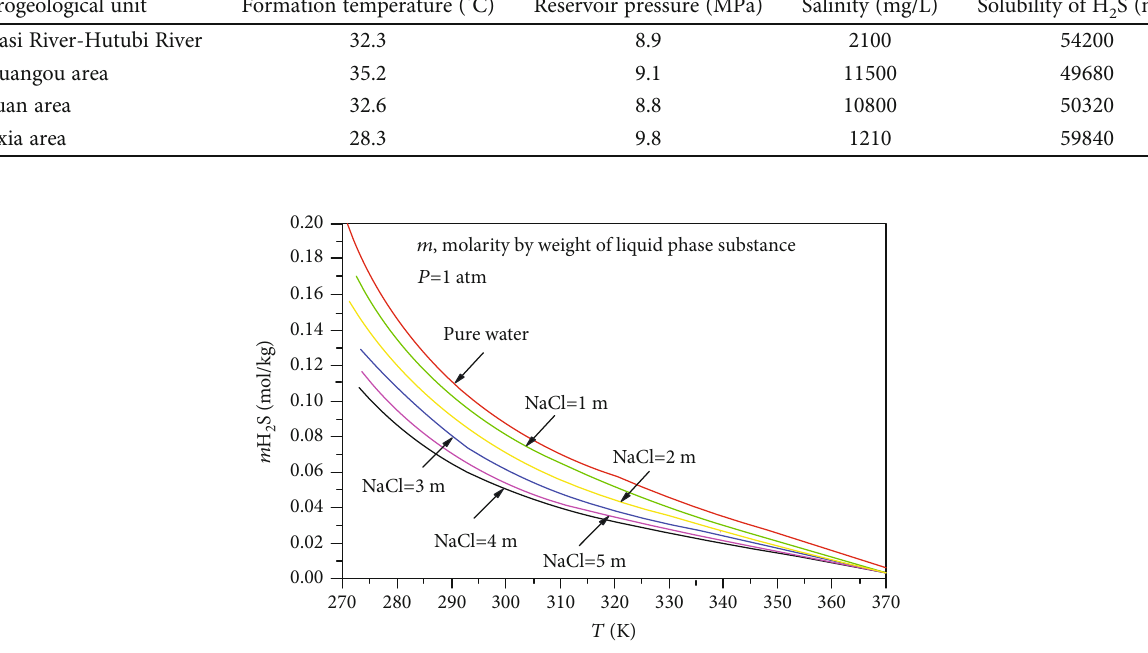
S in pure water and NaCl 2